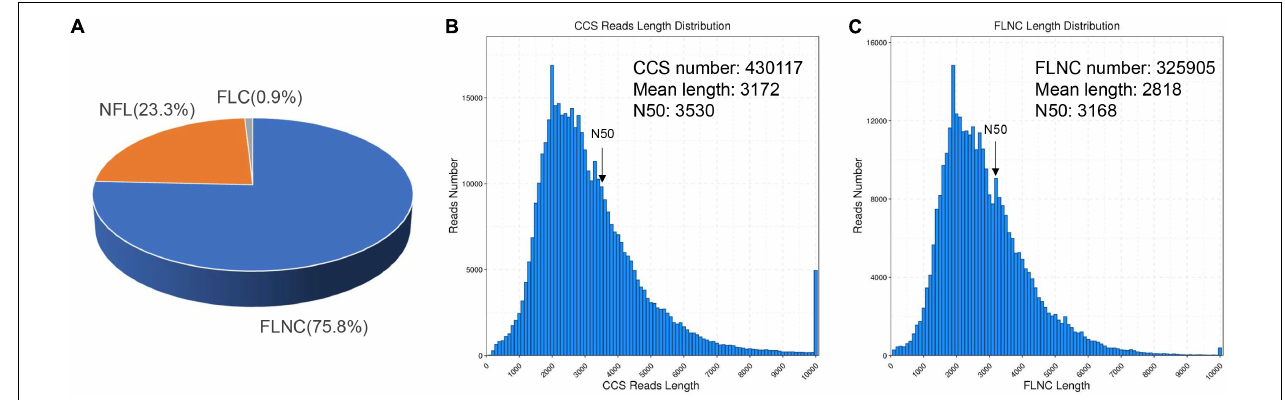
FIGURE 2 | Summary of PacBio SMRT sequencing. (A) The classification of circular consensus sequence (CCS) reads in SMRT sequencing of P. tunicoides hairy root cultures. The percentage of full-length non chimera (FLNC), non–FL (NFL) and full-length chimera (FLC) reads. (B,C) The number and length distributions of CCS (B) and FLNC (C) reads.